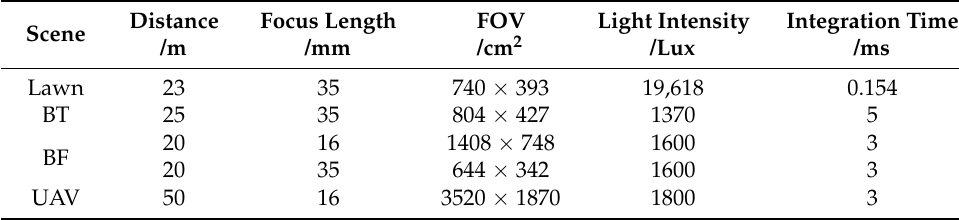
Table 1. The basic parameters of the